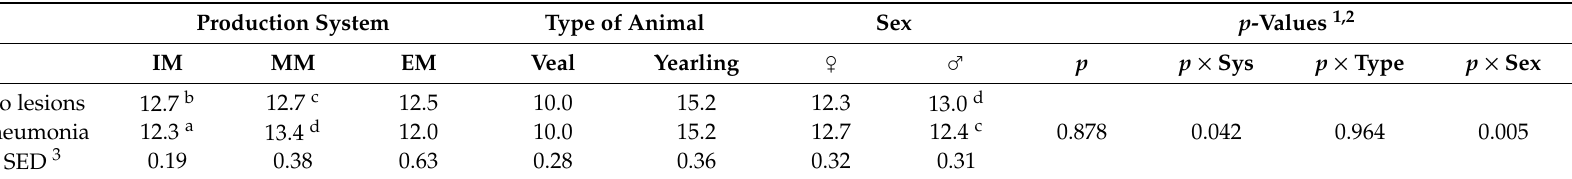
Table 5. E ff ect of the subclinical pneumonia on age at slaughter (months) at slaughter for the di ff erent production (IM: intensive management; MM: mixed management; EM: extensive management), type of animal (Veal vs. Yearling) and sex. Production